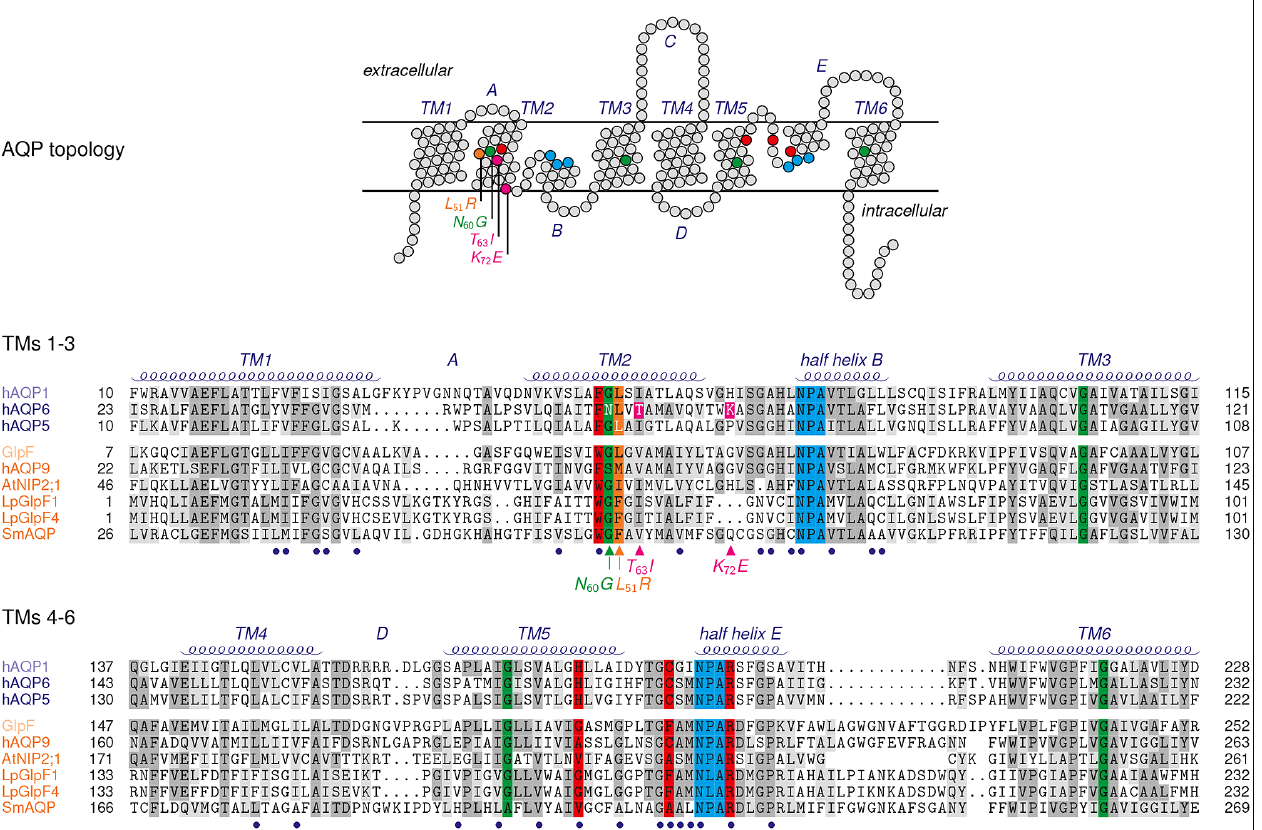
the connecting loop C are excluded from the sequence alignment. Blue bullets below the sequences mark residues of the AQP channel lining. The sequences are grouped according to their subfamily attribution, i.e., the water specific type (AQP1, AQP6, AQP5) and aquaglyceroporins ( Escherichia coli GlpF, human AQP9, NIP2;1, LpGlpF1 and LpGlpF4,